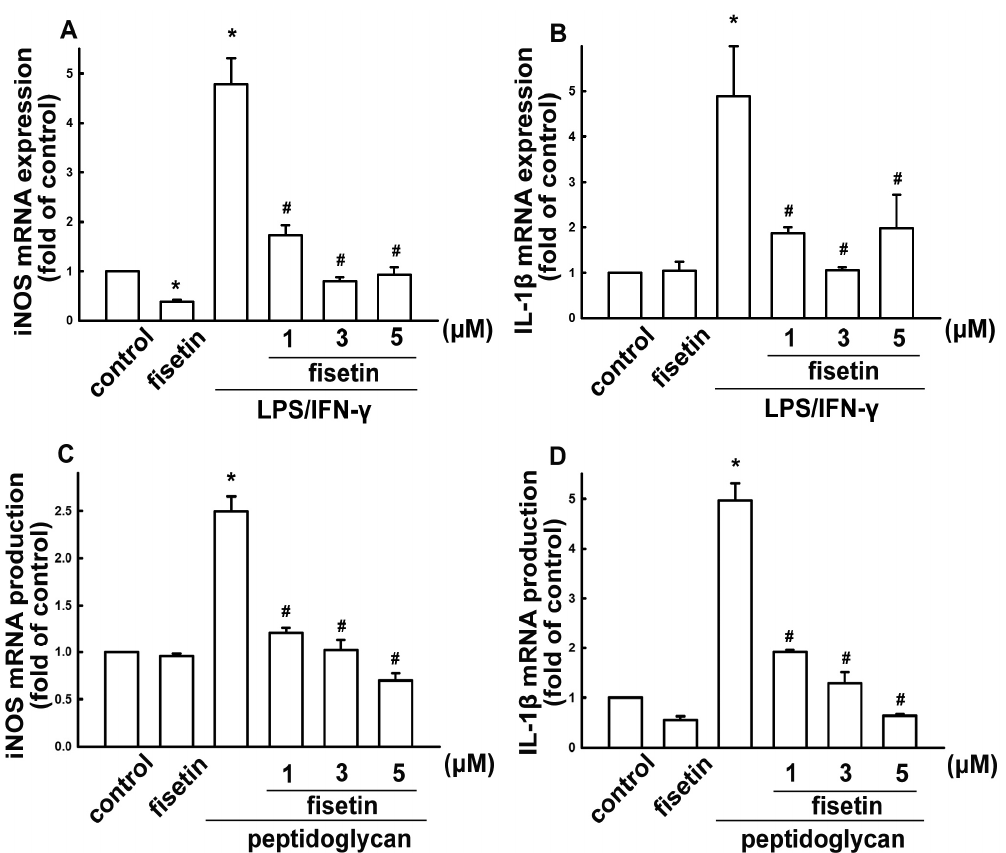
Figure 3. Inhibitory effect of fisetin on LPS/IFN- γ - or peptidoglycan-stimulated iNOS and IL-1 β expressions. BV-2 microglial cells were pretreated with different concentrations of fisetin (1, 3, or 5 μ M) for 60 min, then challenged with LPS plus IFN- γ ( A , B ), or peptidoglycan ( C , D ) for another 6 h. The expression of iNOS and IL-1 β were determined by real-time PCR. Cytokine expression was significantly different between the LPS/IFN- γ (or peptidoglycan) alone and the LPS/IFN- γ (or peptidoglycan) with fisetin groups. The results are expressed as mean ± S.E.M. from 3 to 4 independent experiments. * p < 0.05 compared with the control group; # p < 0.05 compared with the LPS/IFN- γ treatment alone